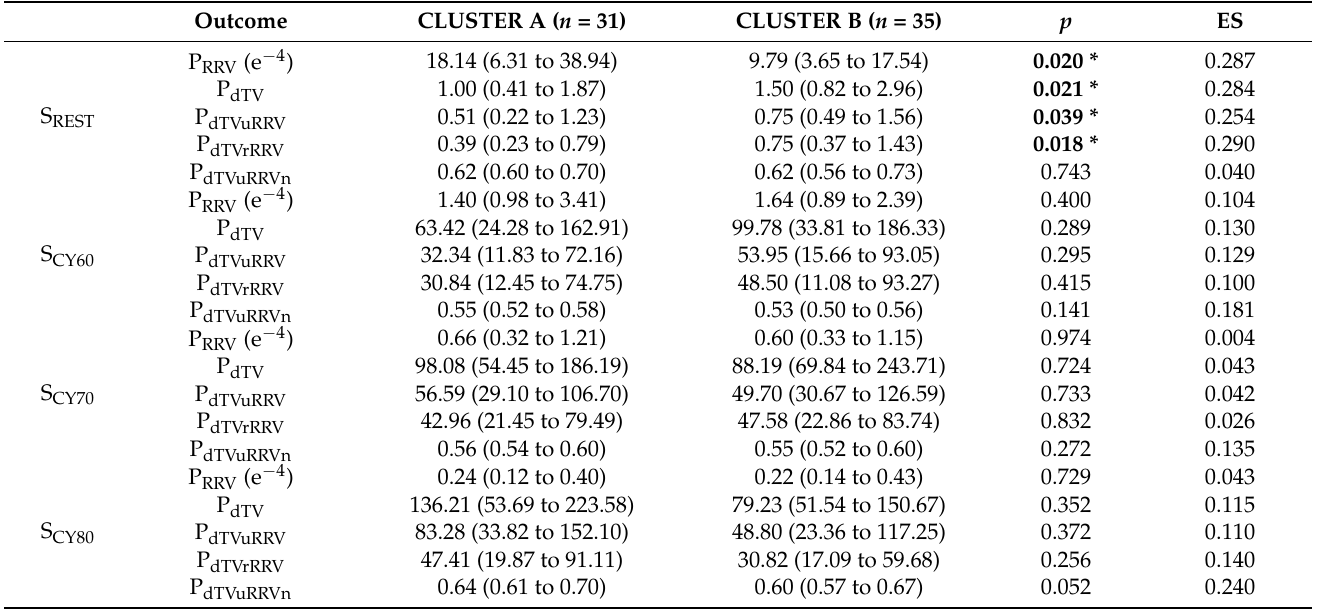
Table 3. Comparison of P RRV , P dTV , P dTVuRRV , P dTVrRRV and P dTVuRRVn between cluster